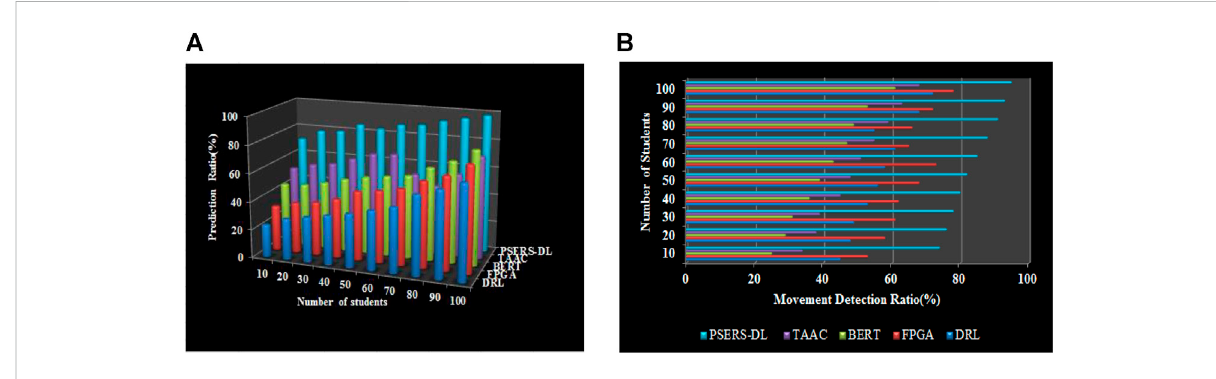
FIGURE 8 (A) Prediction ratio. (B) Movement detection ratio.